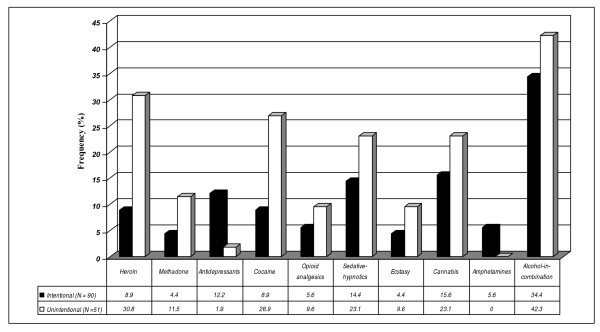
Implicated drugs in FIUI.